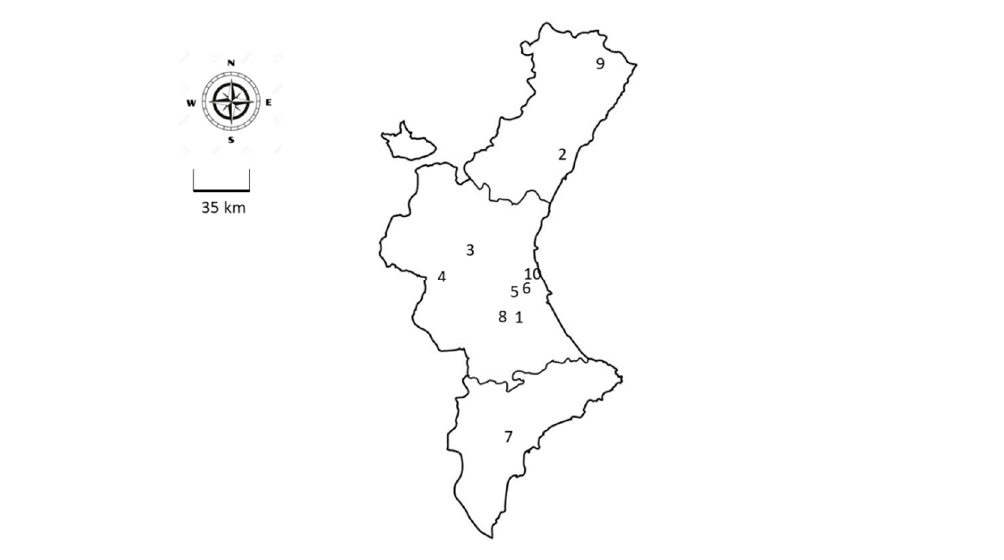
Figure 1. Locations selected in the Valencian region (Spain). 1: Alzira, 2: Burriana, 3: Villar del Arzobispo, 4: Caudete de las Fuentes, 5: Sollana, 6: Silla, 7: Callosa d’en Sarria, 8: L’Alcúdia, 9: Sant Jordi, 10: Viveros-Valencia city. Table 2. Overall concentrations (P + G) detected in all sampling sites of the pilot scheme ( N =